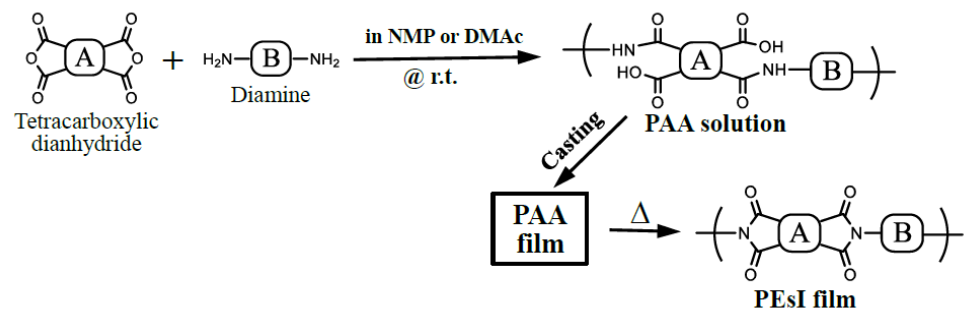
Figure 4. Schemes of polyaddition, solution casting of PAAs, and thermal imidization for PEsI film preparation.